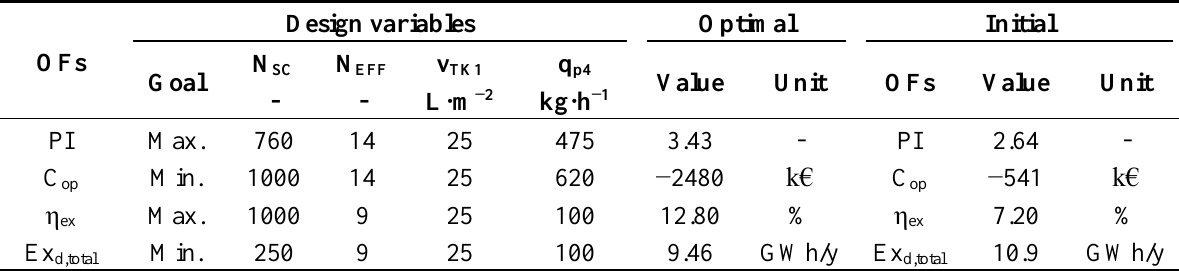
Table 2. Optimal values for the objective functions of optimization analysis and comparison with initial